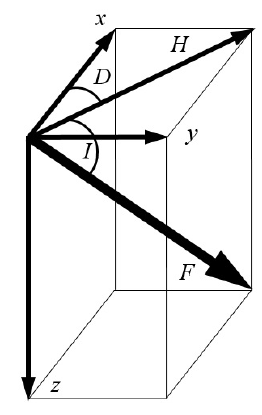
Figure 1. The components of magnetic